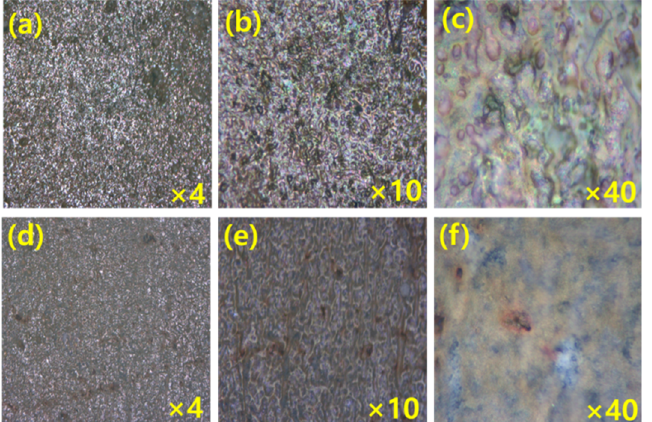
Figure 6. The MS surface images ( a – c ) after 1 h dipping, and ( d – f ) after 3 h dipping in 1 M H 2 SO 4 at different magnifications.